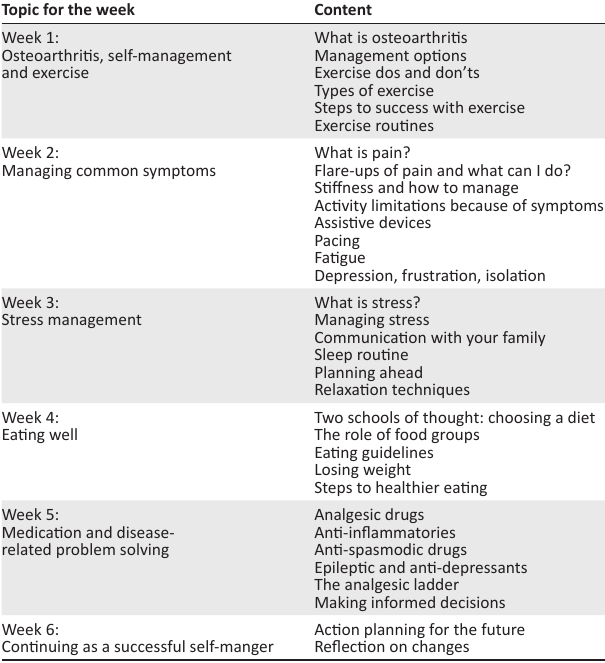
TABLE 1: Topics and content of the ‘Living with Osteoarthritis’